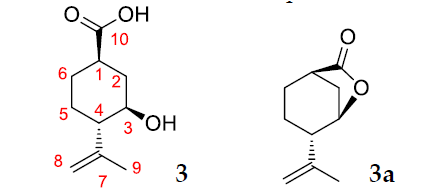
Figure 10. Structures 3 and 3a .